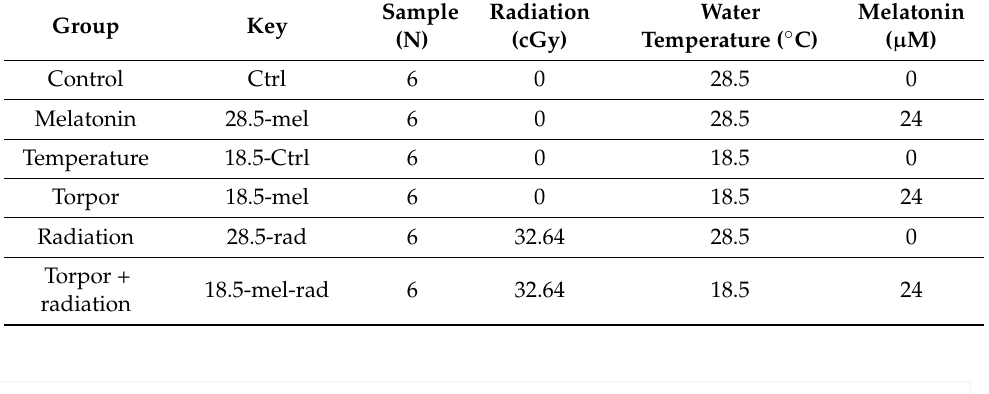
Table 1. Overview of the experimental groups showing the experimental group names, key, sample number per condition, values of radiation exposure, ambient water temperature and melatonin treatment.